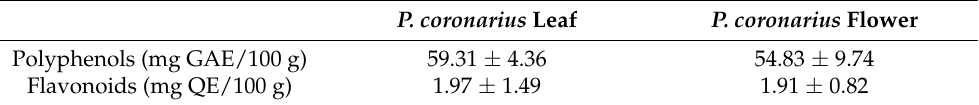
Table 4. Total polyphenol and flavonoid content ± SD of P. coronarius leaf and flower.